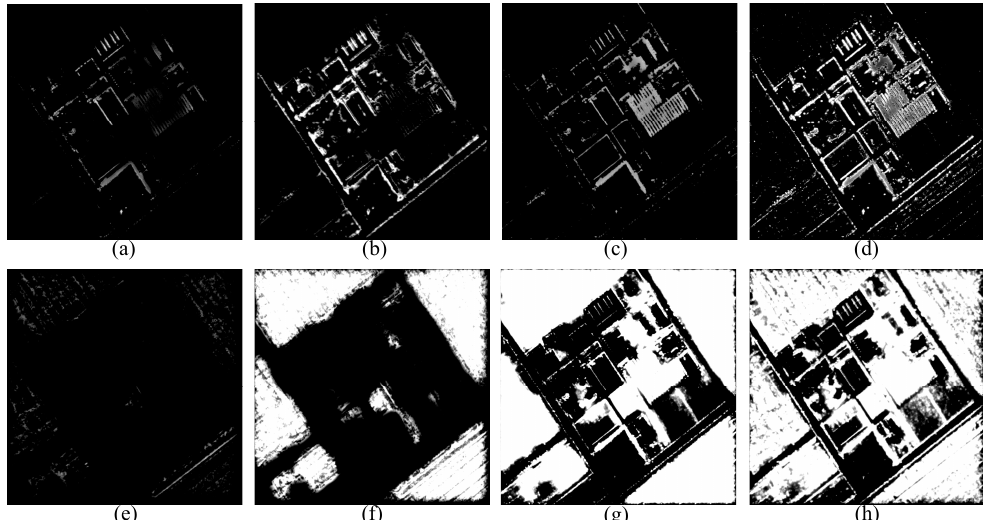
Figure 13. Visualization of deep features extracted by the multitask feature extractor on the X-band SAR image. ( a – d ) describe the details of heterogeneous building regions. ( e – h ) describe the edges of homogeneous natural